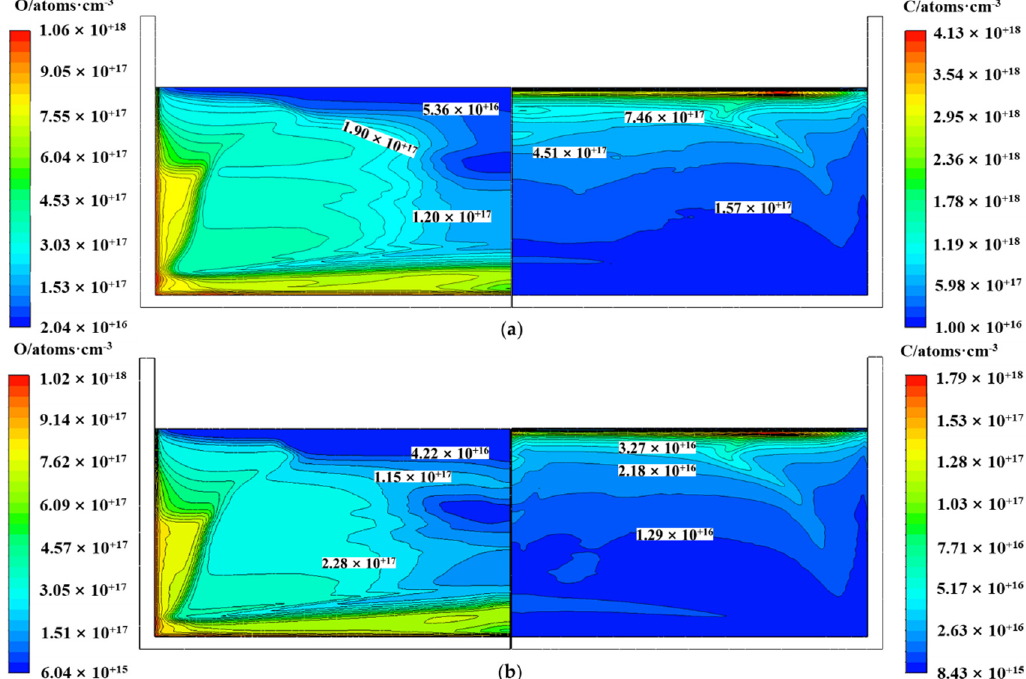
Figure 11. The concentration distributions of O and C in the silicon ingots at the 100% crystalline fraction without ( a ) and with ( b ) the AGDS.